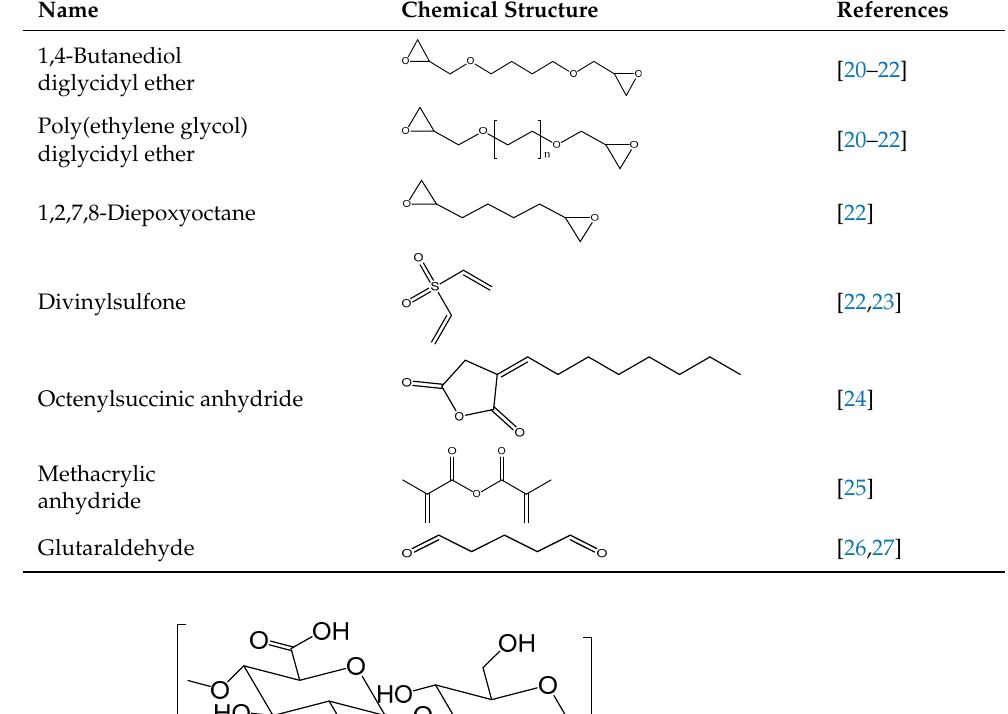
Table 1. Commercially used crosslinkers for HA’s hydroxyl group modifications.